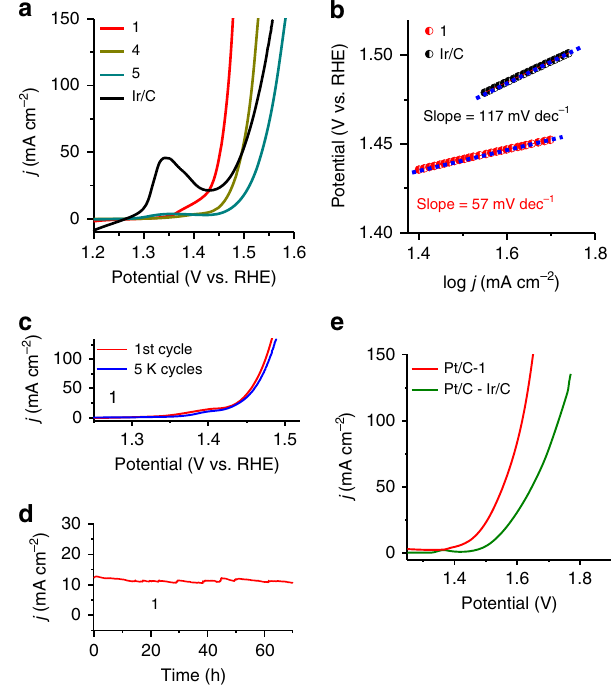
Fig. 4 Electrochemical performance of electrocatalysts toward OER and whole-cell water splitting. a Linear sweep voltammograms (LSVs) curves measured in 1 M KOH at a scan rate of 5 mV s − 1 . b Tafel slope. c LSVs recorded at a scan rate of 5 mV s − 1 during the OER before and after continuous polarization of the electrode in 1 M KOH for 5000 cycles. d Chronoamperometry curves recorded in 1 M KOH for 70 h. e Current density of Pt/C- 1 vs. Pt/C-Ir/C for overall water splitting in 1 M KOH. 1: Fe 3 Co(PO 4 ) 4 @rGO, 4: Fe 2 P 2 O 7 )@rGO, 5: (CoFe 2 O 4 )(Fe 2 O 3 )@rGO. Source data for a and c – e are provided as a Source Data fi